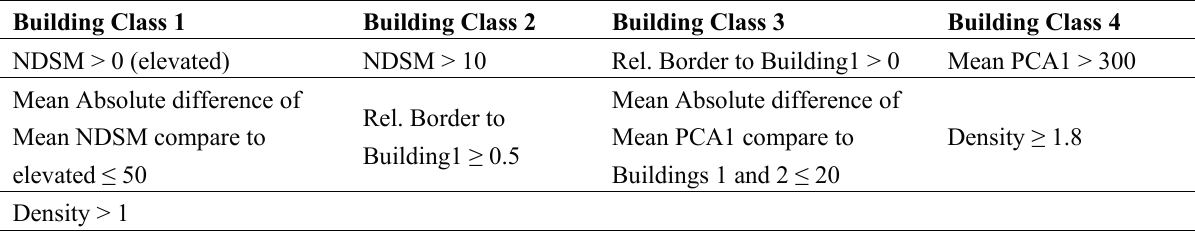
Table 3. Classification specification for building classes.